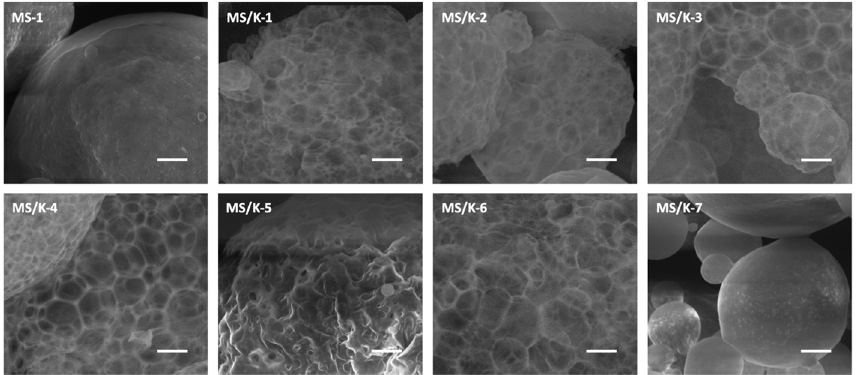
Figure 3. Effect of synthesis parameters on MS surface characteristics. Scale bar: 5 µ m; magnification: 7000 ×.